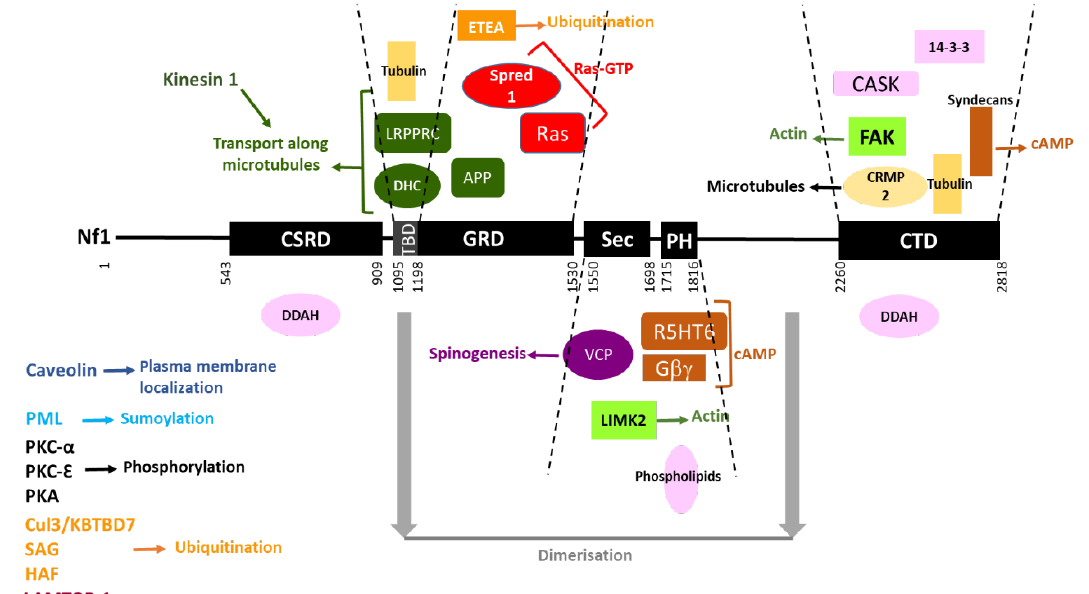
Figure 14. Neurofibromin interacting partners. Neurofibromin domains are indicated as black boxes and their limits are written below. Interacting partners of each domain are pictured between the dashed lines delimiting the domains. Each type of function is represented by a color: Ras-GTP in red, cAMP in brown, actin dynamics in green, microtubules in yellow, transport along microtubules in dark green, spinogenesis in purple, ubiquitination in orange, sumoylation in blue, phosphorylation in black, plasma membrane localization in dark blue, and unknown function in pink. Regions necessary for neurofibromin dimerization are indicated in grey. Partners interacting with unknown domains of neurofibromin or being part of the same complex are not pictured but their name is indicated on the left side of the